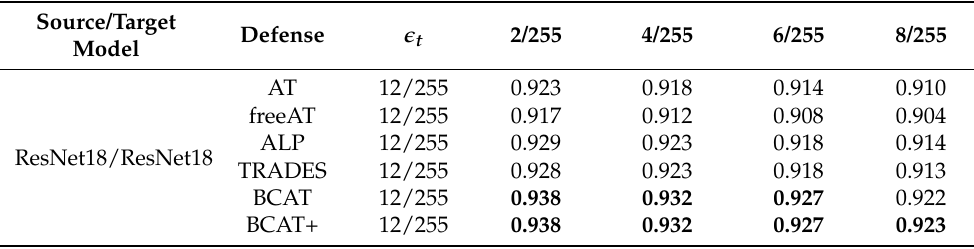
Table 6. Comparing the black-box adversarial robustness generalization accuracy of different defense methods on